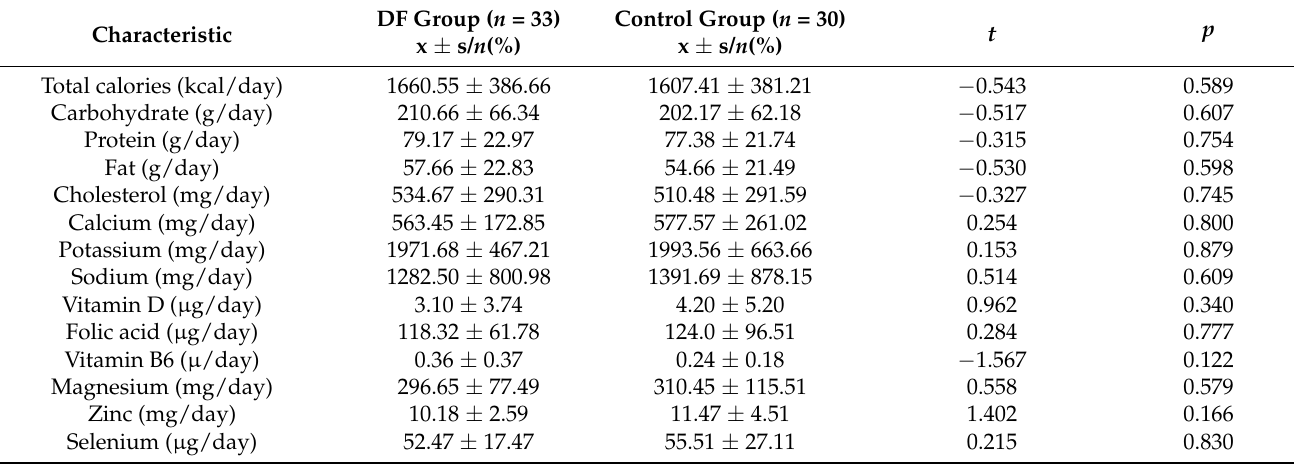
Table 2. Comparison of qualities of dietary nutrition (except DF) intake between two groups at baseline.